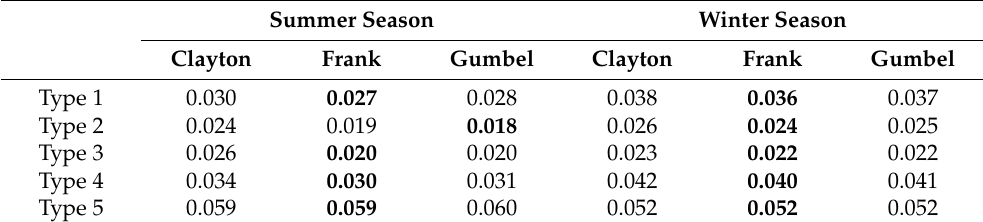
Table 4. RMSEs in probability values for different copulas and rainfall